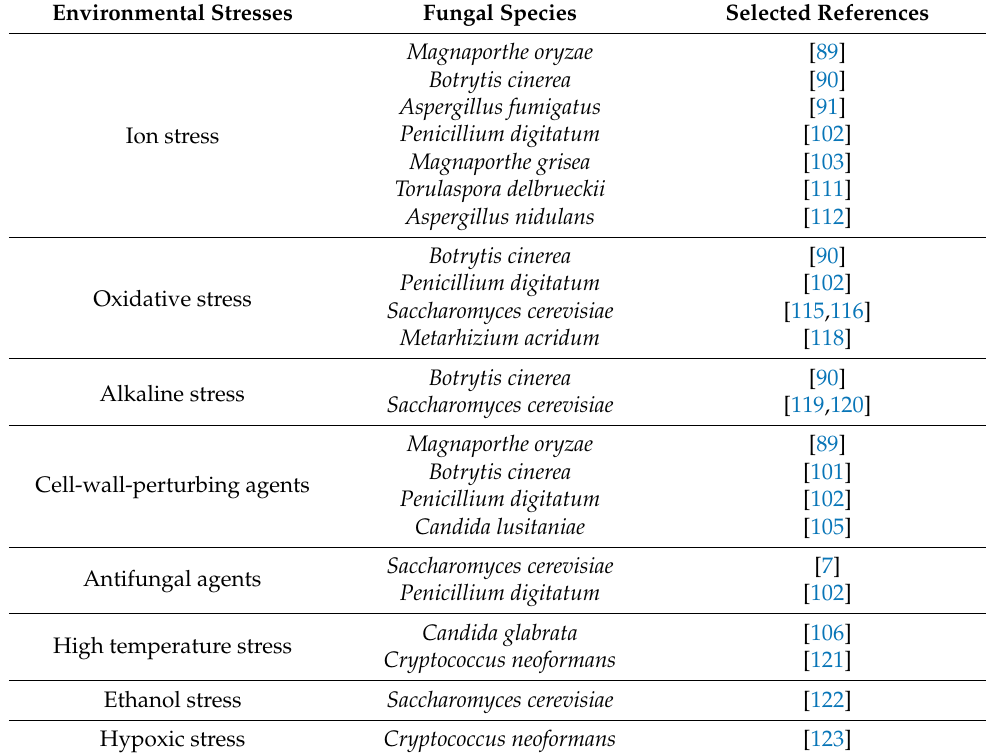
Table 2. Stress responses regulated by transcription factor Crz1 in